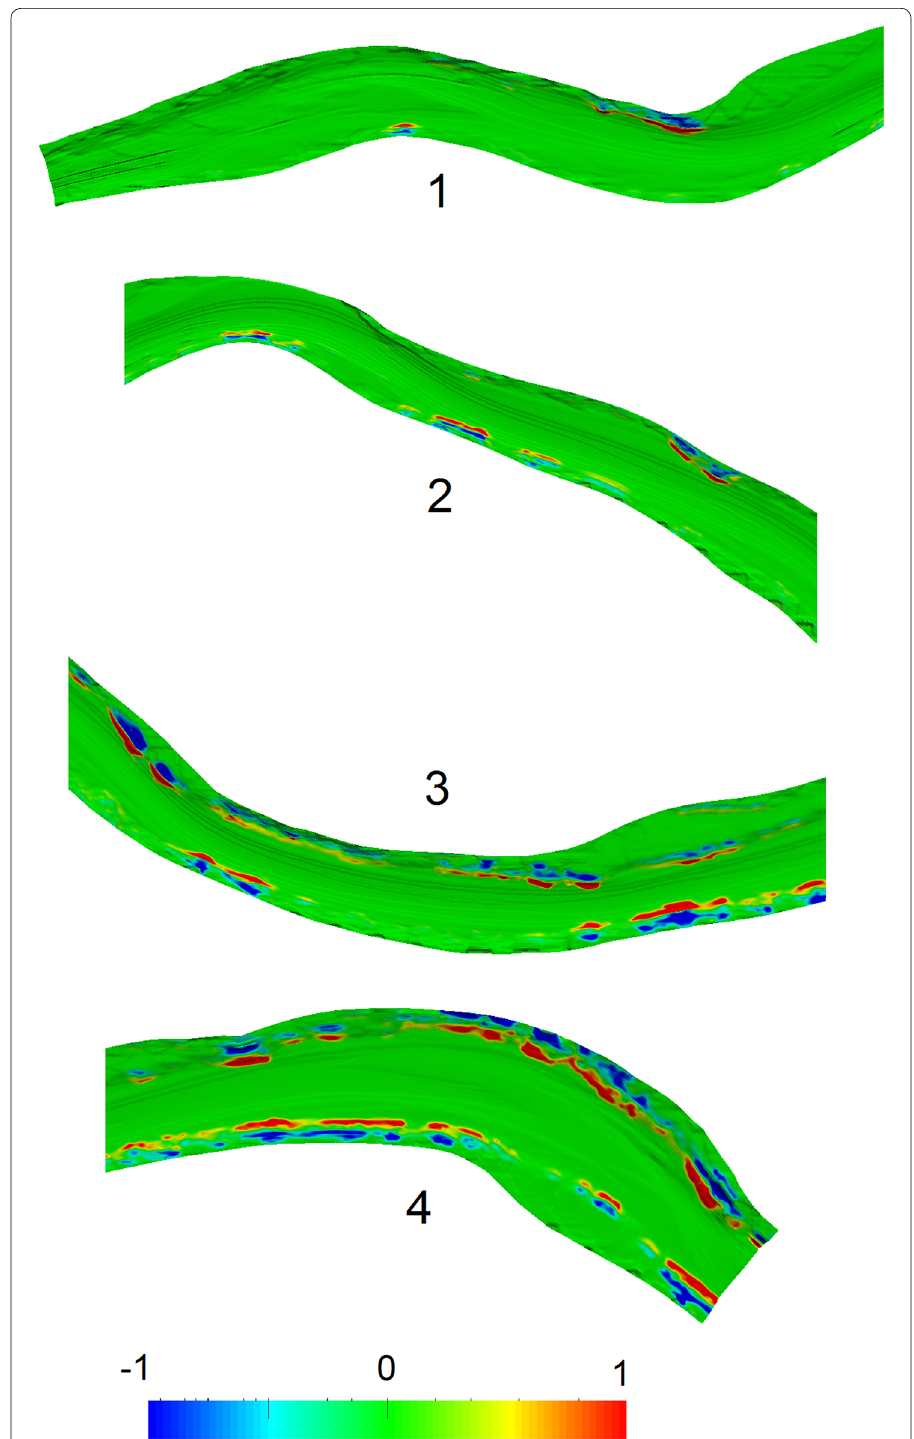
Fig. 15 Detailed plan view of four parts of the reservoir, where the colours show the computed bed elevation changes in meters due to the slide movements. The four sections are numbered in the flow direction, where 1 is the most upstream located part and 4 is the most